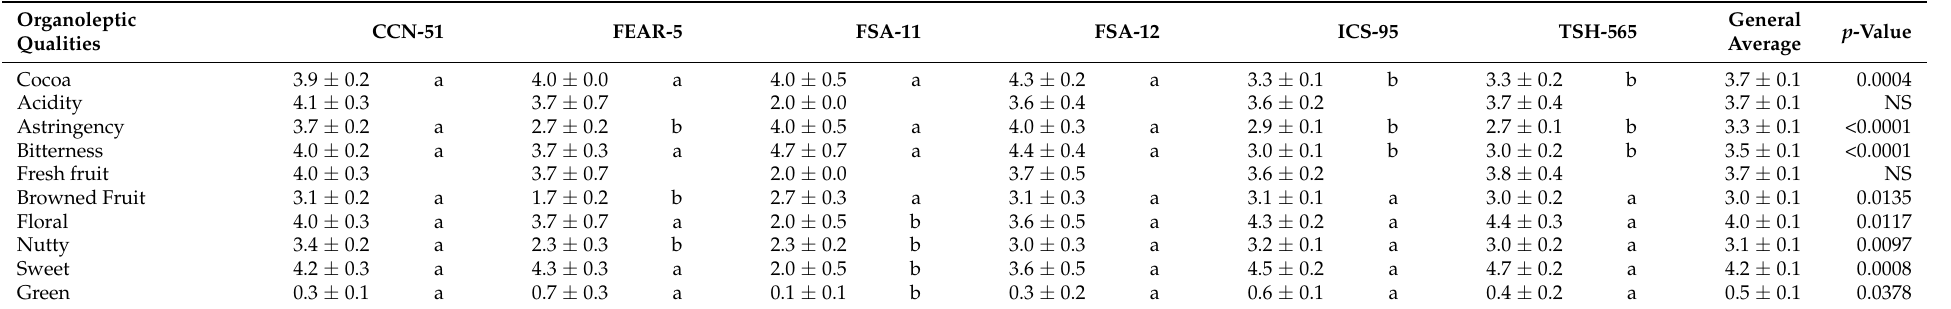
Table 2. Mean and standard error of organoleptic qualities of cocoa clones from the department of Meta, Colombia. Organoleptic